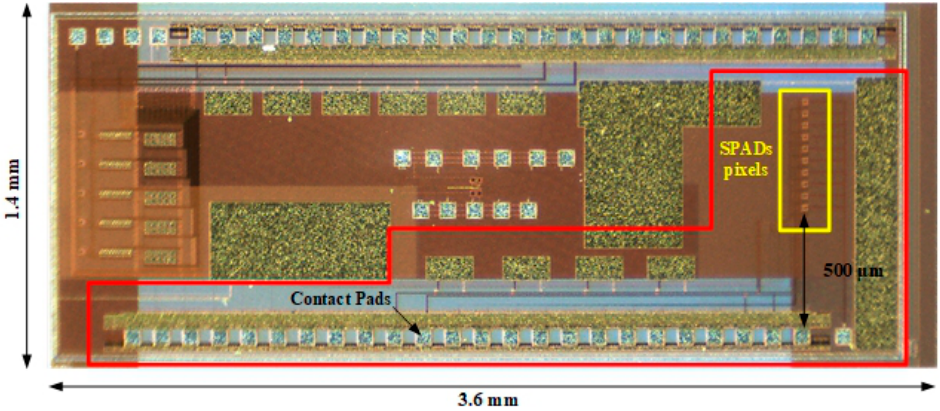
Figure 3. Photography of the ASIC with the implemented circuit highlighted in red and the 10 SPADs pixels highlighted in yellow. The first SPAD pixel is situated at 500 µm from the edge of the contact